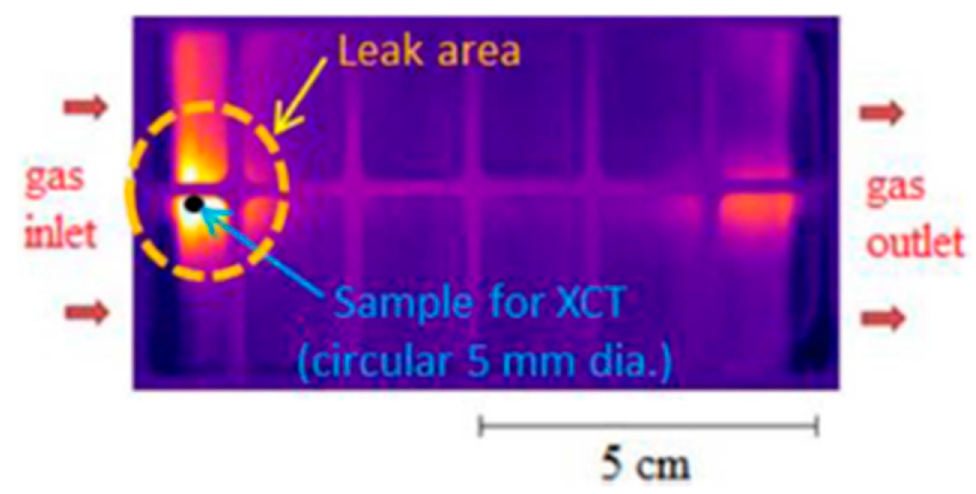
Figure 2. Infrared image of failure MEA in pure mechanical degradation [18].